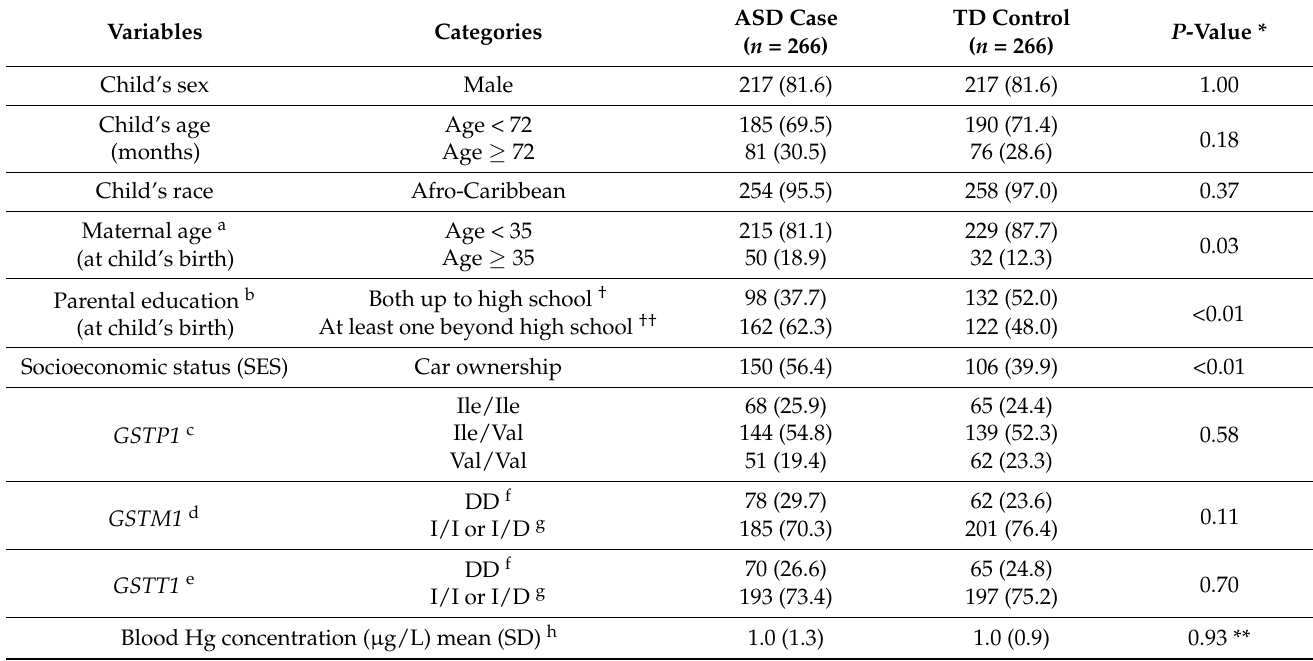
Table 1. Children and Parents’ characteristics by ASD case status (266 matched